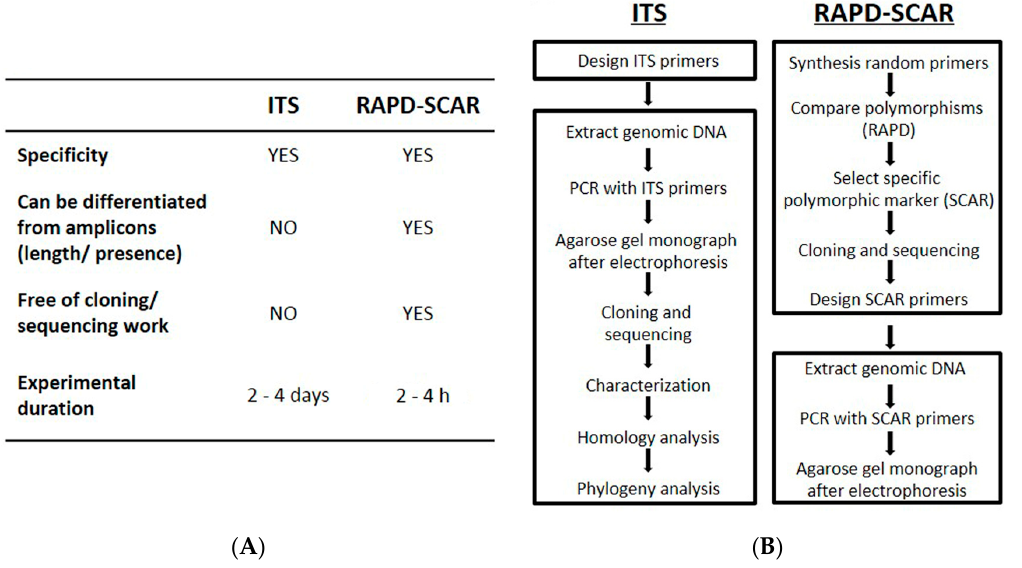
Figure 6. Comparison of ITS sequences and the RAPD-SCAR method. ( A ) The characteristics of the ITS and RAPD-SCAR methods; ( B ) workflow of the ITS and RAPD-SCAR methods.